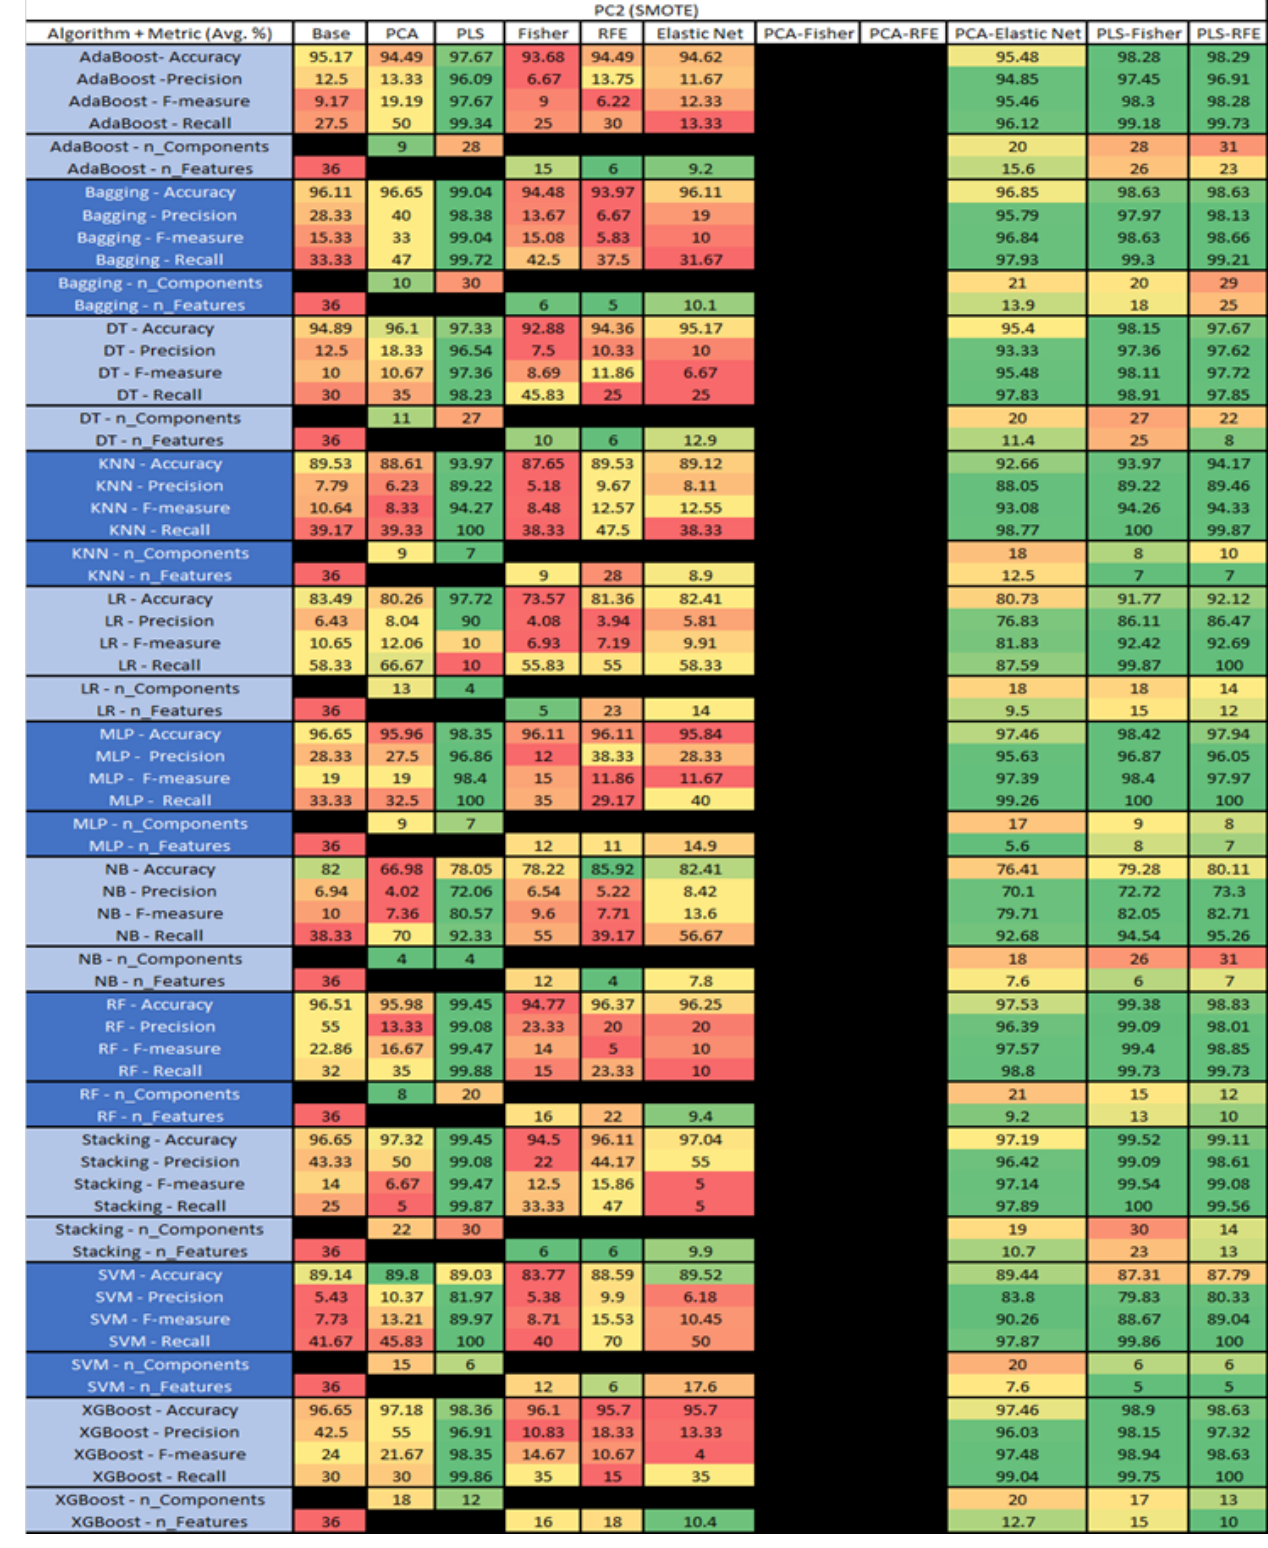
Figure 43. PC2 SMOTE NASA MDP Results Data